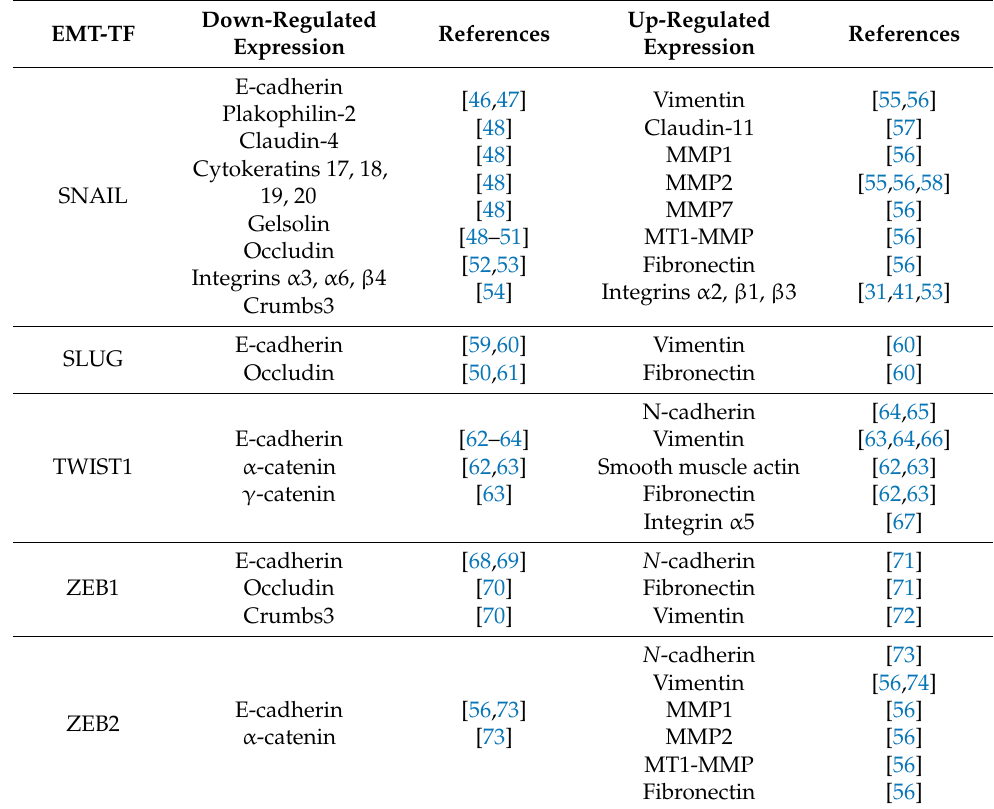
Table 1. EMT transcription factors and their